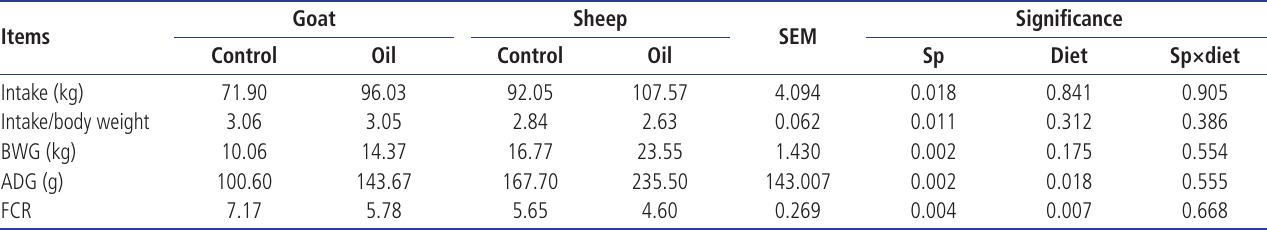
Table 3. Feed intake, body weight gain, average daily gain, and feed conversion ratio of goat and sheep fed with and without linseed oil supplementation over 100 days experiment Goat Sheep Items